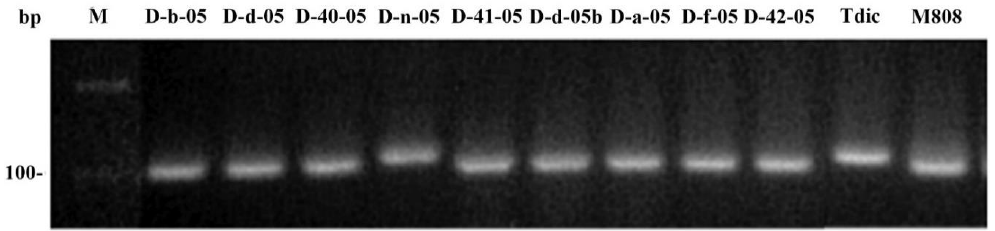
Figure 3. PCR of genomic DNA of alloplasmic lines with primers rps19f/rps19r.